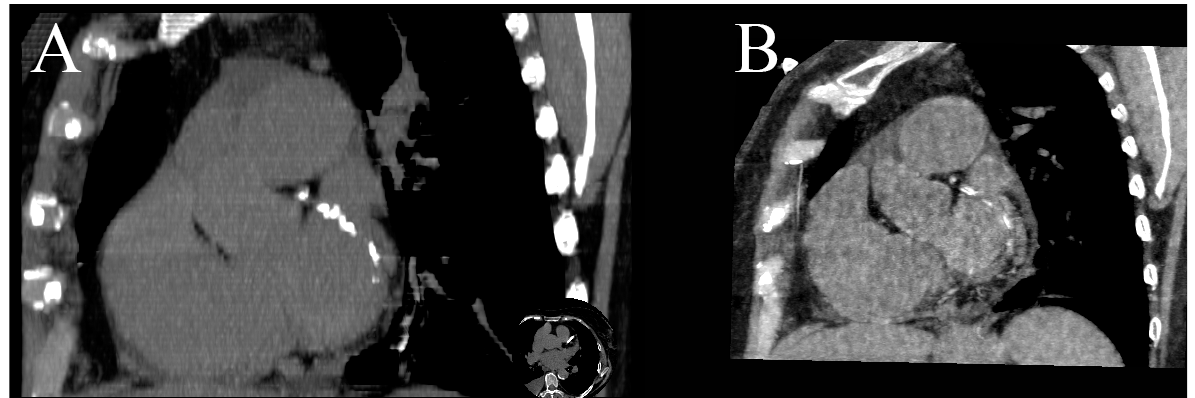
Figure 5. MPR MIP image of true unenhanced image ( A ) and water (iodine) map ( B ) showing calcifications in the LCx. The volume of calculated calcifications was 85 mL and 88 mL, respectively. Similar results, showing high correlation between calcium volume calculated from TUN and VUIs, were reported by [24].